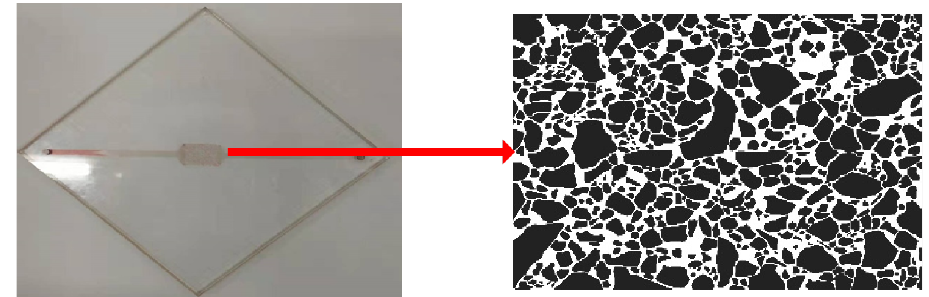
Figure 1. The realized microscopic visual model. 2. The experimental crude oil was ground-degassed crude oil mixed with dye. According to the experimental results, Sudan III was selected to dye the transparent yellow crude oil red. The experimental temperature was 110 °C, and the well-plugging pressure and time at different points were set. This allows the identification of the status of oil and gas at different times. This technique allows a dynamic description of CO 2 injection process at shale oil reservoir condition, in comparison to the static observation such as environmental scanning electron microscopy, laser focusing and micro fluorescence methods.